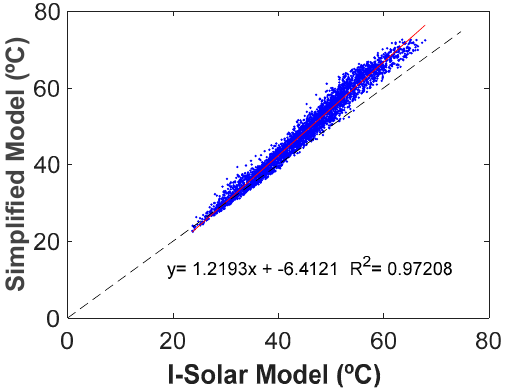
Figure 4. Comparison of estimated cell temperature between simplified and I-Solar model.